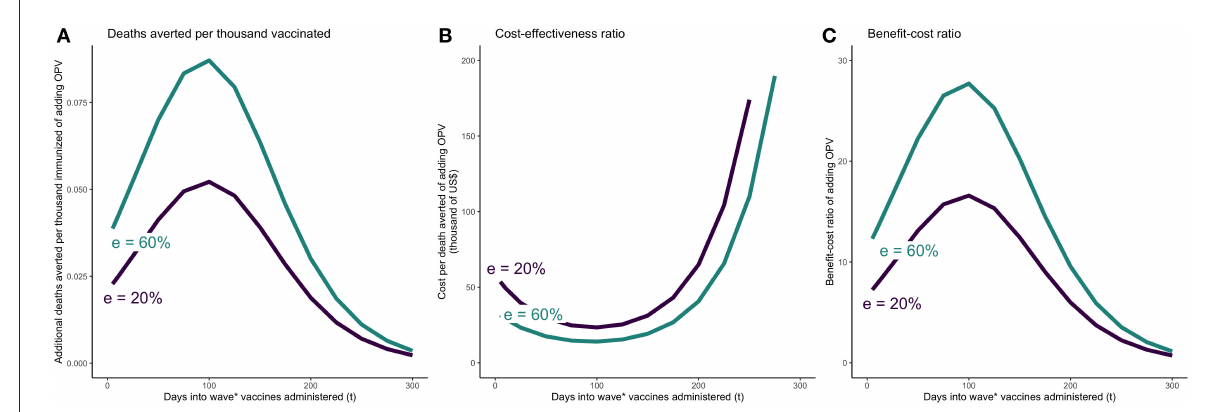
FIGURE2 OPV and COVID-19 vaccine simultaneously administered t days after beginning of epidemic wave—incremental mortality impact, cost-effectiveness, and benefit-cost of adding OPV. (A) Incremental deaths averted per 1,000 individuals of adding OPV to COVID-19 vaccine only schedule. (B) Incremental cost-effectiveness ratio per averted death of adding OPV to COVID-19 vaccine only schedule. (C) Incremental benefit-cost ratio of adding OPV to COVID-19 vaccine only schedule. The results reflect the scenario in which vaccine coverage for both vaccines are set at 30%. OPV is administered simultaneously with the COVID-19 vaccine on day t . The COVID-19 vaccine is assumed to be 74% effective against infections and reducing infectivity, 95% effective against severity, and require 28 days from administration until the it becomes